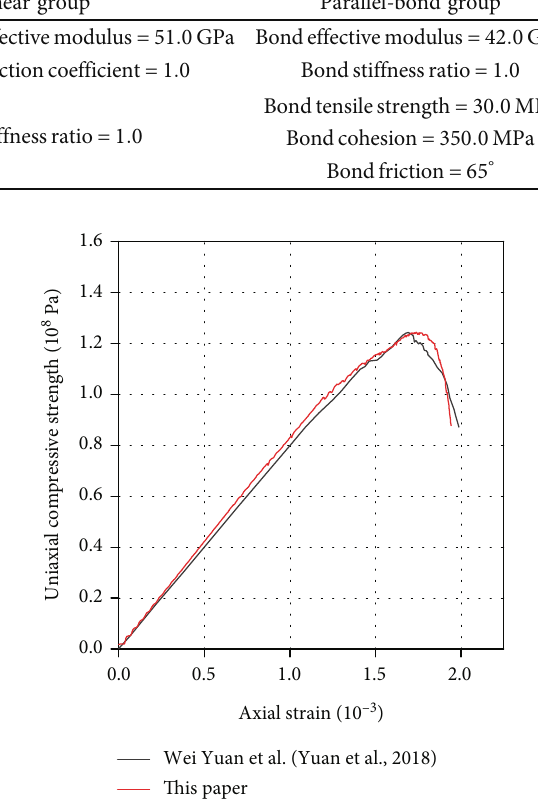
Figure 5: Comparison of uniaxial compression test results of sandstone [35].